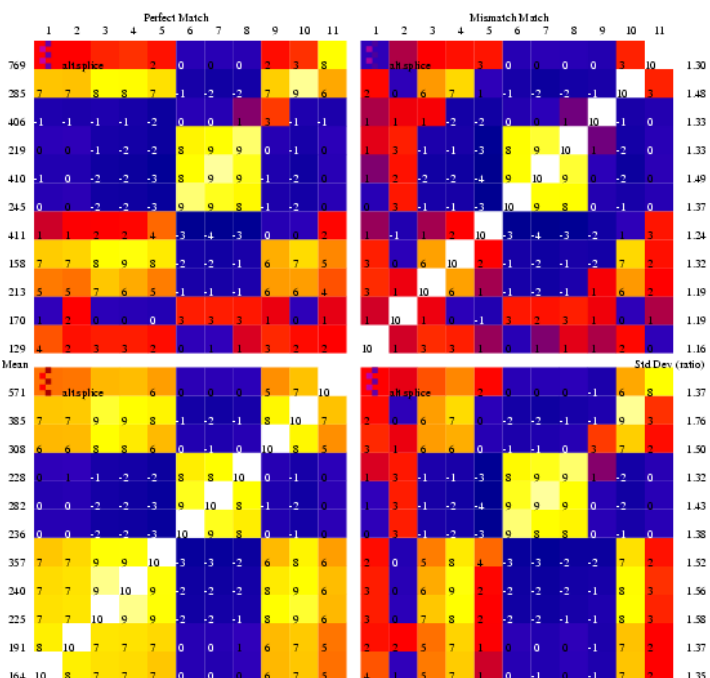
Figure 13: The correlation matrix for probeset 209885 at on the HG-U133A array. All the PM probes map uniquely to one exon, ENSE00001219272, and yet they show two di ff erent correlation blocks (PM 1,2,3,4,5,9,10 and 11 in one block, and PM 6,7 and 8 in the other